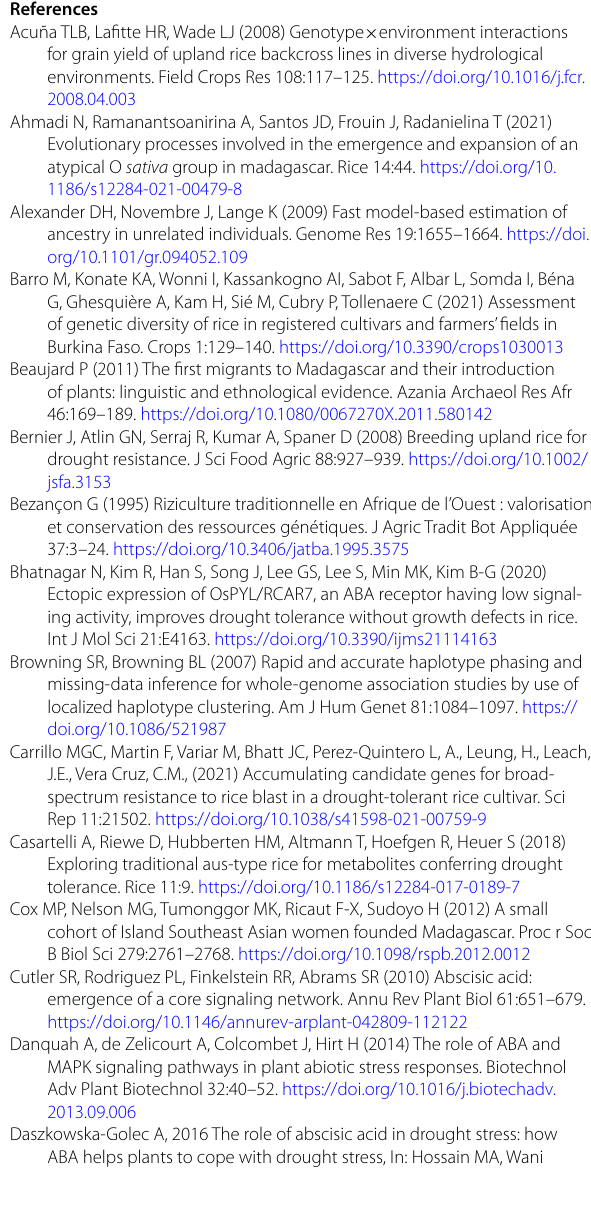
for 12 chromosomes. Figure S3 : ELAI result in West African Upland on chromosome 6. Figure S4 : ELAI result in chromosome 6 with parameter mg 20. Figure S5 : ELAI result in chromosome 6 with parameter mg 50. = = Figure S6 : ELAI result in chromosome 6 with parameter mg 100. Figure = S7 : ELAI result in chromosome 6 with parameter mg 1000. Figure S8 : = Comparison between PCA-KDE and ELAI results. Figure S9 : Pairwise Fst comparison between intercontinental Tropical japonica populations. Figure S10 : Pairwise Fst comparison between GJ-trop Int vs others + subgroups of GJ-trop. Figure S11 : Pairwise Fst comparison between tropi- cal japonica populations. Figure S12 : Pairwise Dxy comparison between GJ-trop Int vs others subgroups of GJ-trop. Figure S13 : Pairwise Dxy + comparison between tropical japonica populations. Figure S14 : Pairwise Pi comparison between tropical japonica in chromosome 6. Figure S15 : Trees constructed on 100 Kb internal to the right and left extremities of the Int1 introgression. Figure S16 : Unweighted NJ tree between cAus and West African tropical japonica rice. Figure S17 : Unweighted NJ tree using 900 Kb internal segment between 25.8 and 26.7 Mb (Int2). Figure S18: Trees built on 100 Kb of the left and right borders of the Int1 and Int2 introgressions respectively. Figure S19 : iHS statistic result in Asian tropical japonica. Figure S20 : SNPs density along 12 chromosomes Additional file 2. Table S1: The most significant biological process enrichments considered in this study. Retrieved from https:// shiny apps. south green. fr/ app_ direct/ goenr ich/. Table S2: 291 Tropical japonica accessions from both Africa and Asia. Table S3: Detailed analysis of the cAus introgression on chromosome 6, located between 17.9 and 21.7 Mb. Table S4: Tropical japonica accessions having Int1 (Int1a and Int1b) cAus introgression on chromosome 6 are listed below. Table S5: Results of Patterson’s D statistic using ABBA-BABA tests. Table S6: iHS genomic scan results on chromosome 6 of the West African tropical japonica popula- tion. Table S7: Tropical japonica, cAus, NERICA and glaberrima accessions groups used for TreeMix analysis. Table S8: Results of Patterson’s D, fd and fdM statistic using ABBA-BABA tests on chromosome 6. Table S9: 2710 accessions samples from Africa and Asia. This table was adapted from the additional data in the article Wang and al. 2018: https:// www. nature. com/ artic les/ s41586- 018-